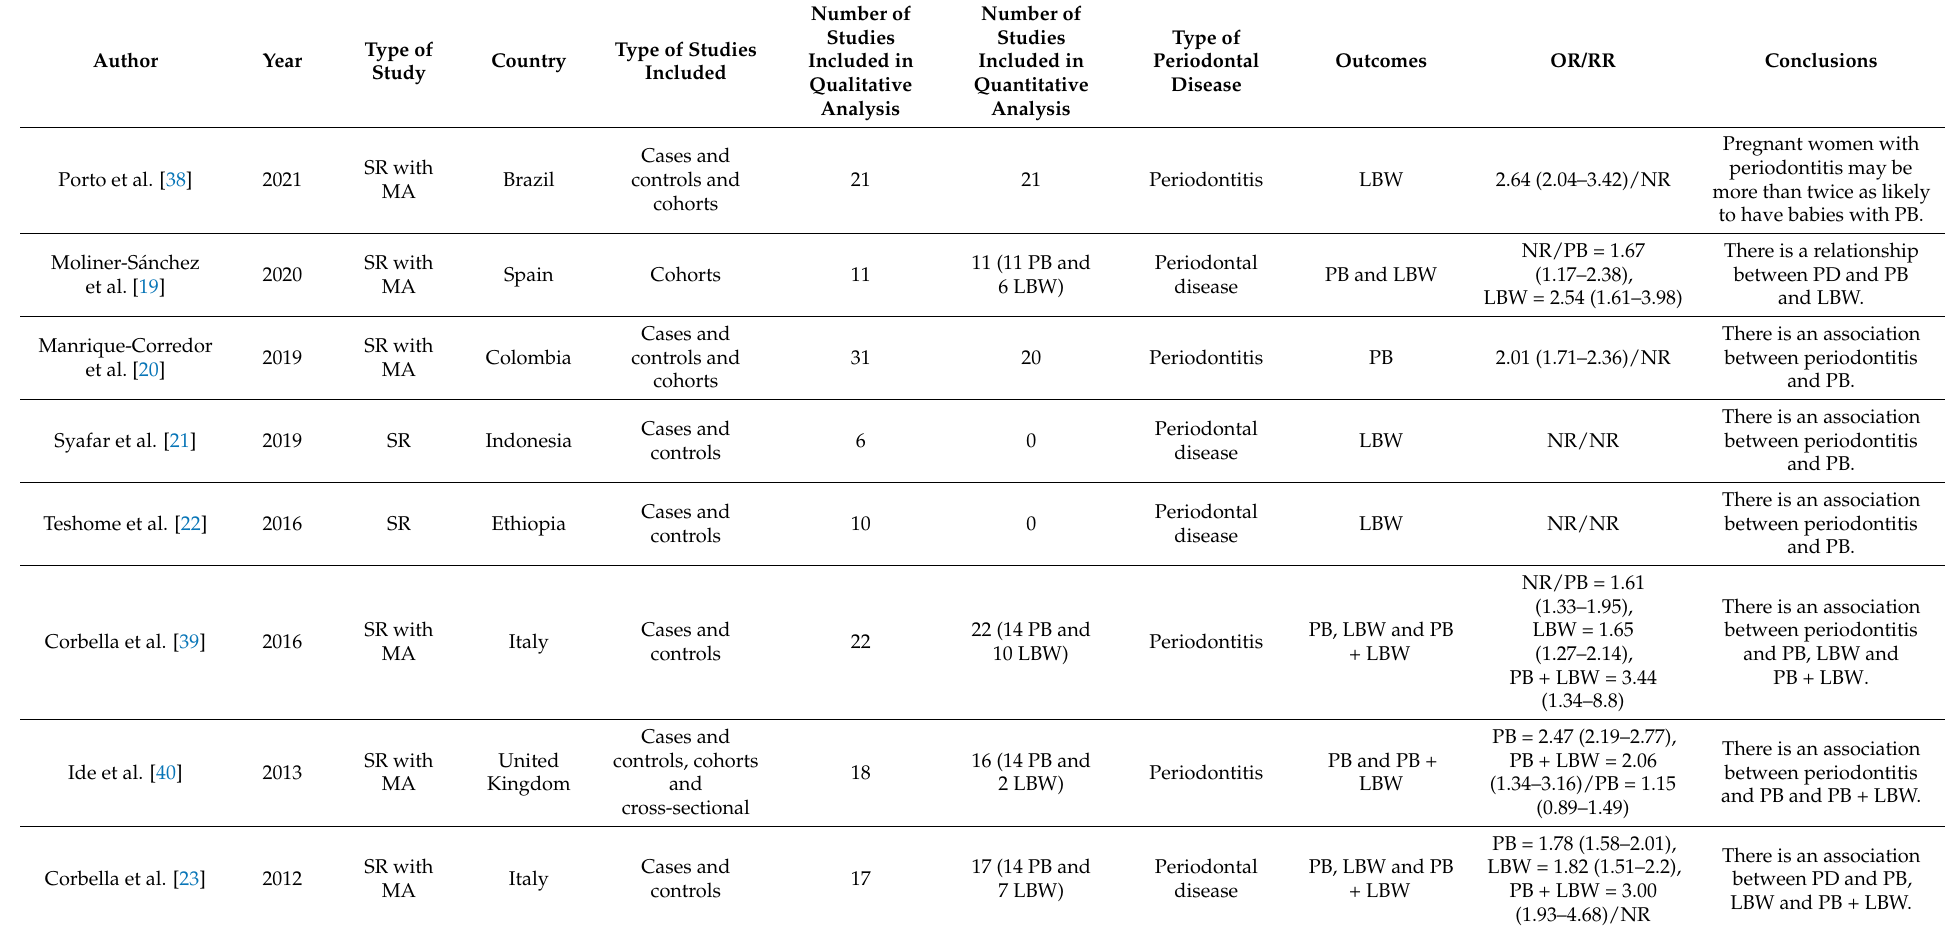
Table 3. Characteristics of the included